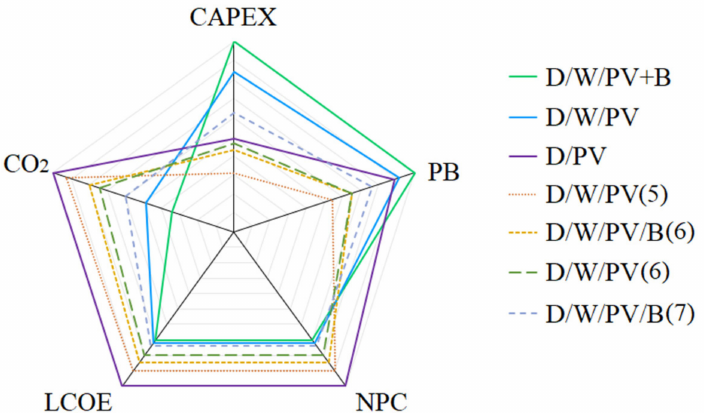
Figure 7. The main HES performance indicators of some configurations with and without restrictions on the PB.